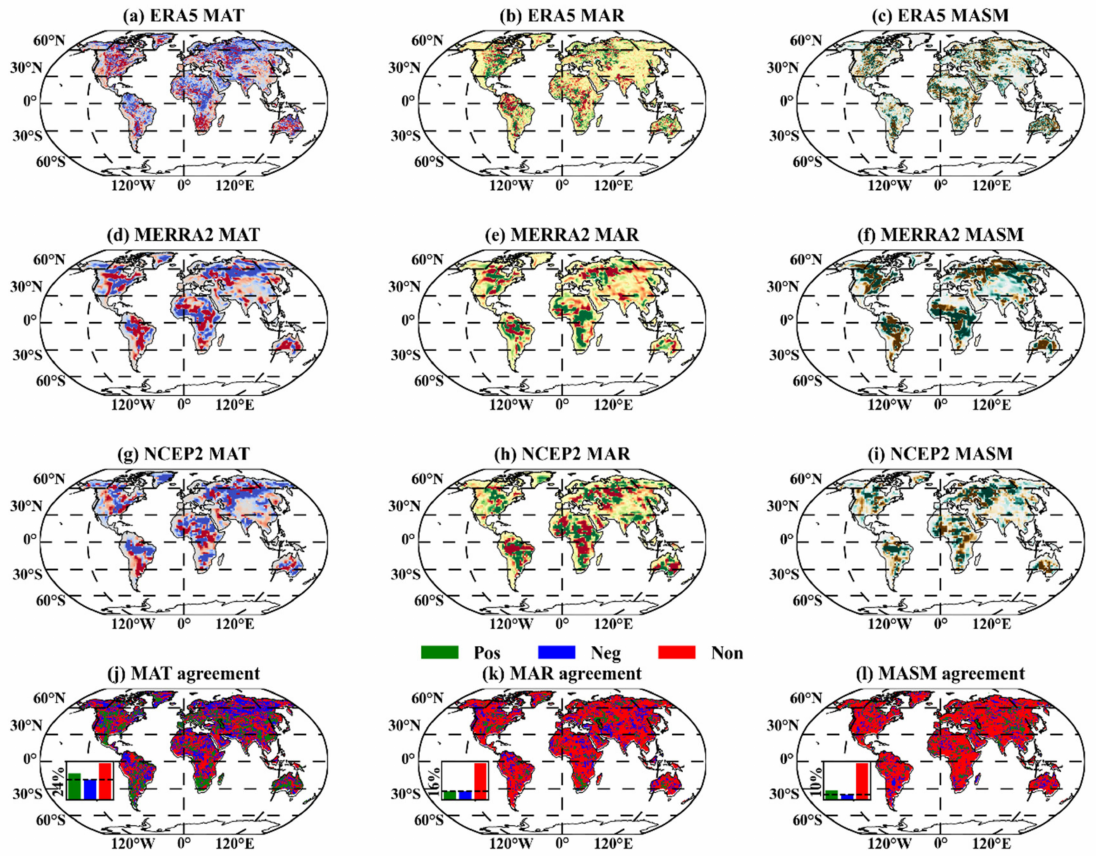
Figure 8. Spatial patterns of the slope of MAT ( a , d , g ), MAR ( b , e , h ), and MASM ( c , f , i ) (derived from ERA5, MERRA2, and NCEP2) along EG and their spatial consistencies ( j , k , l ) from 2001 to 2020. The frequency of the uncertainty value is in the left of subfigures ( j , k , l